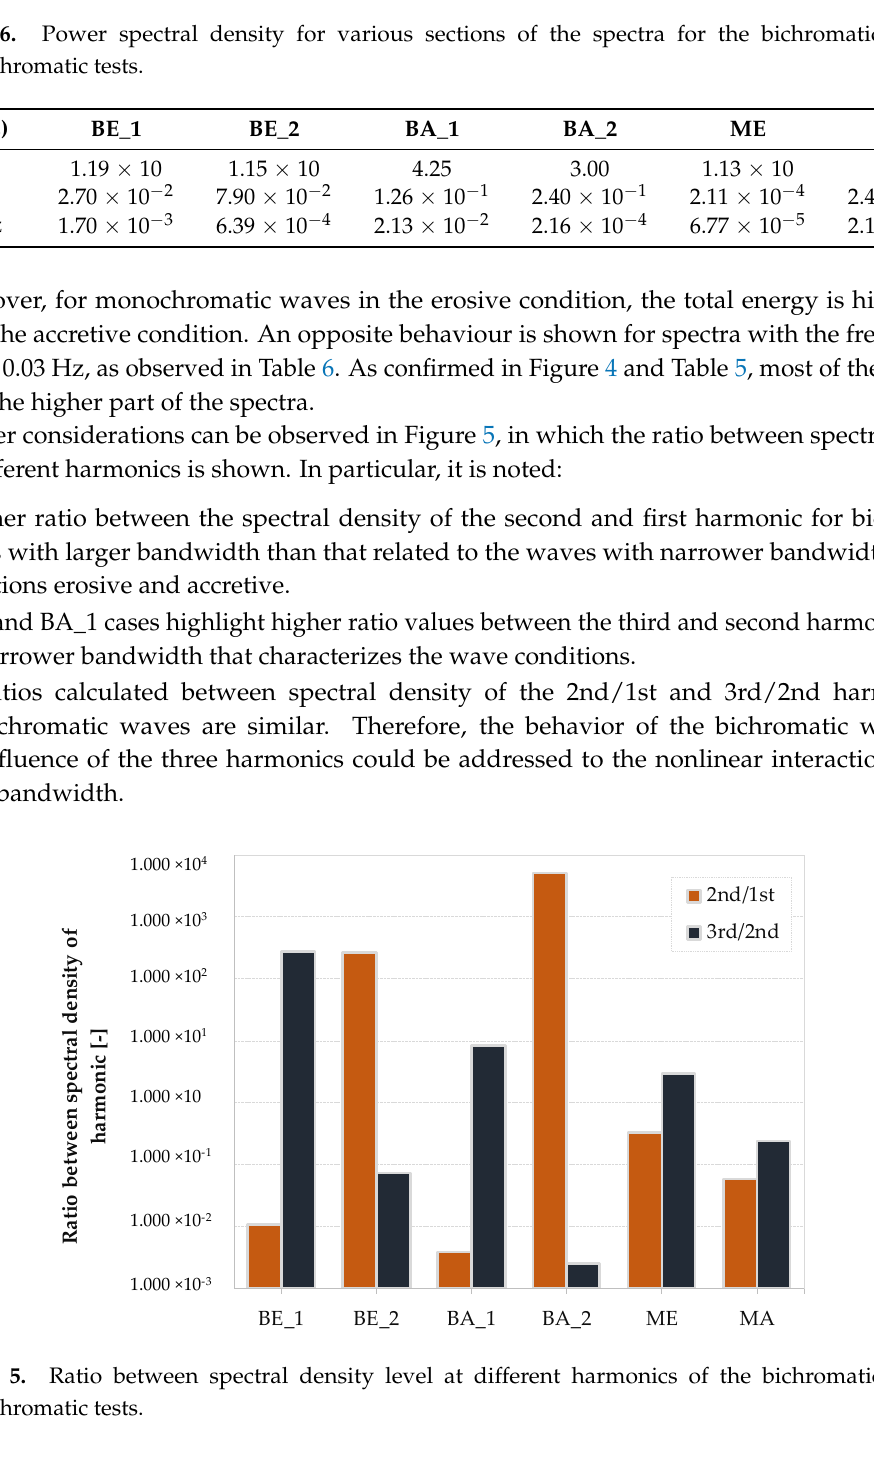
Table 5. Peak frequencies, periods and power spectral density for monochromatic tests under erosive (ME) and accretive (MA) conditions. Power spectral density for various sections of the spectra for the bichromatic and monochromatic tests.